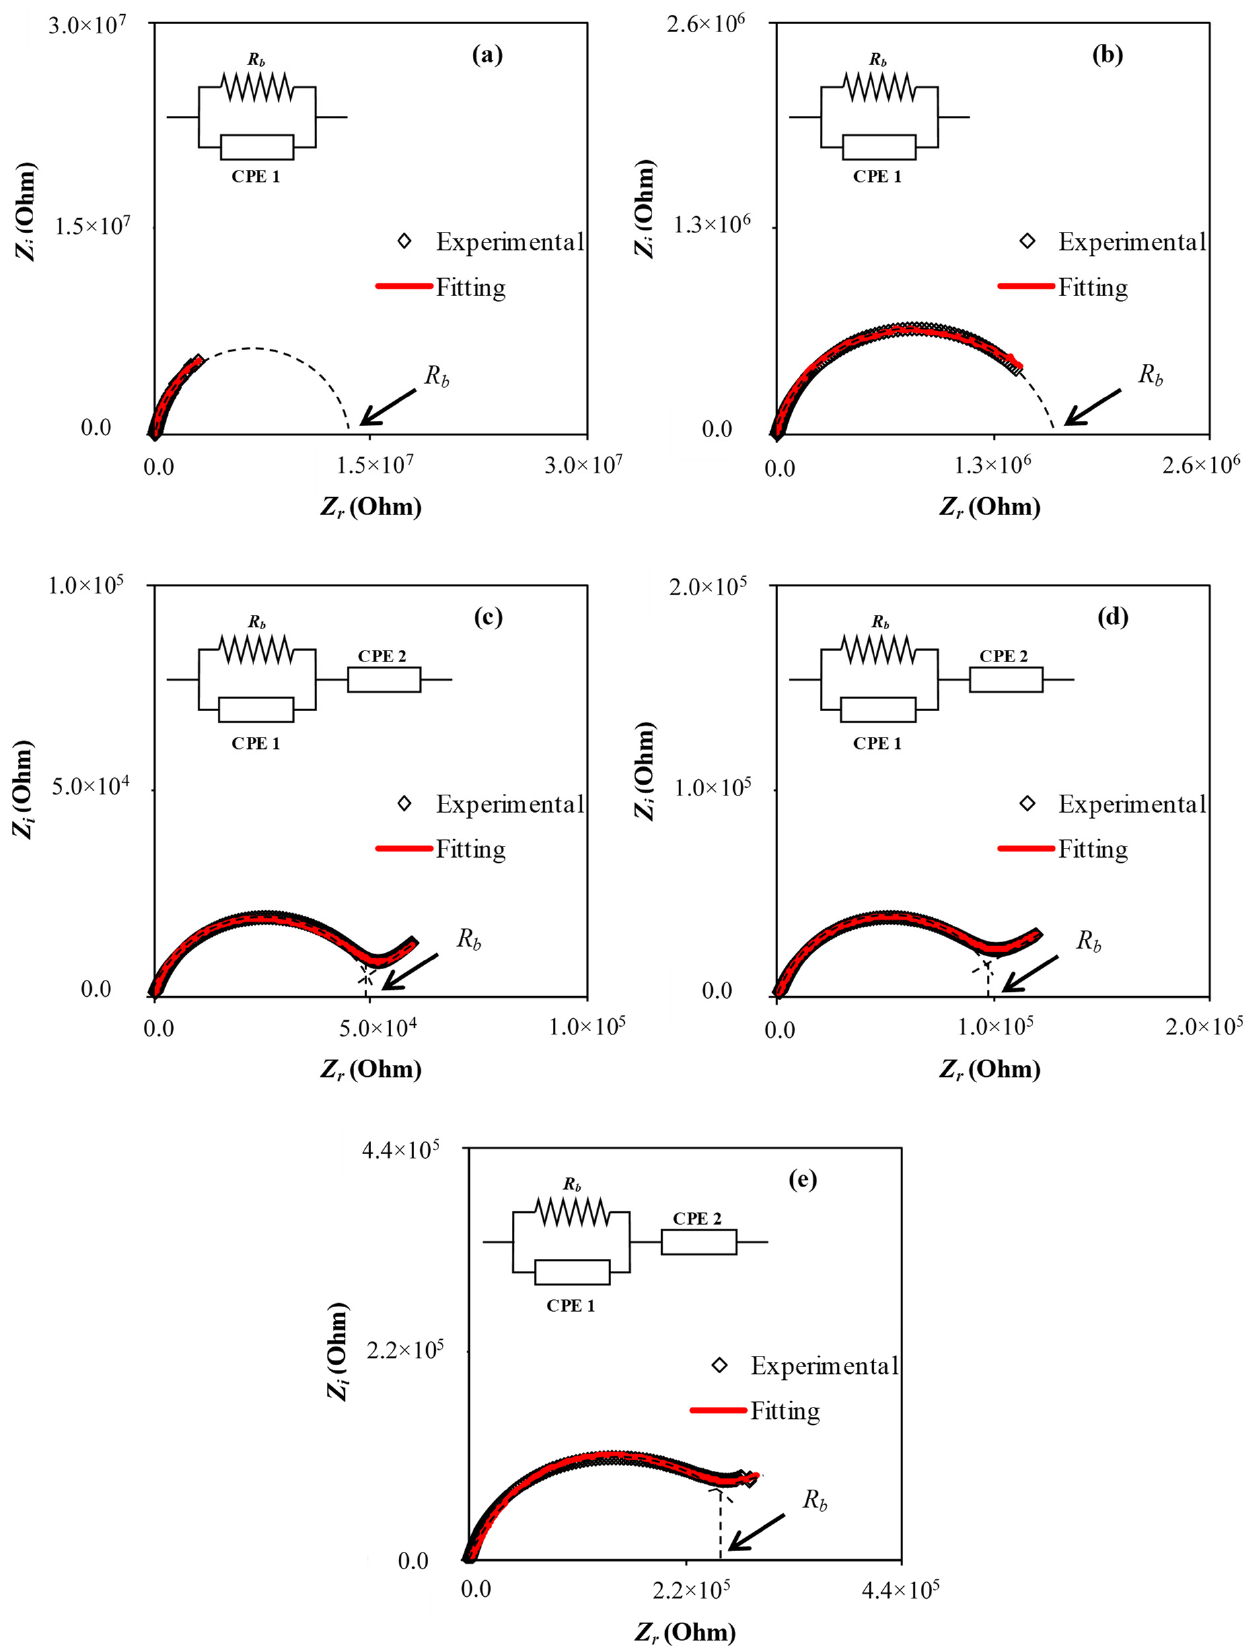
Figure 2. The EIS and simulated data for ( a ) MCK1, ( b ) MCK2, ( c ) MCK3, ( d ) MCK4, and ( e ) MCK5. In the right-hand side model, there is a second term Z CPE known as the impedance of the constant phase element. Here, the reciprocal of capacitance is K , and the deviation of the inclined line from the real axis is represented by p . If p has the value of unity, 𝑍 𝑅 − (cid:3037) . Whereas, when p is zero, a perfect resistor is considered instead of the constant (cid:3104)(cid:3004)